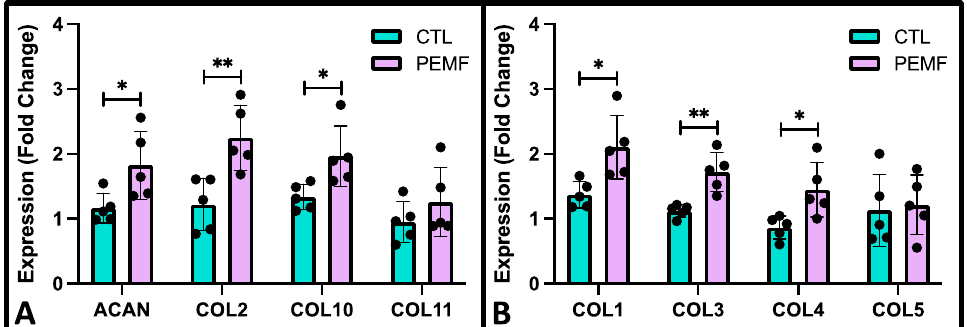
Figure 14. Gene expression of bovine cartilage explants normalized to day 0 controls using ( A ) cartilage (ACAN, COL2, COL10, COL11) and ( B ) synovium (COL1, COL3, COL4, COL5) ECM markers following 7 days of PEMF stimulation with parallel untreated controls ( n = 6; * p < 0.05, ** p < 0.01).